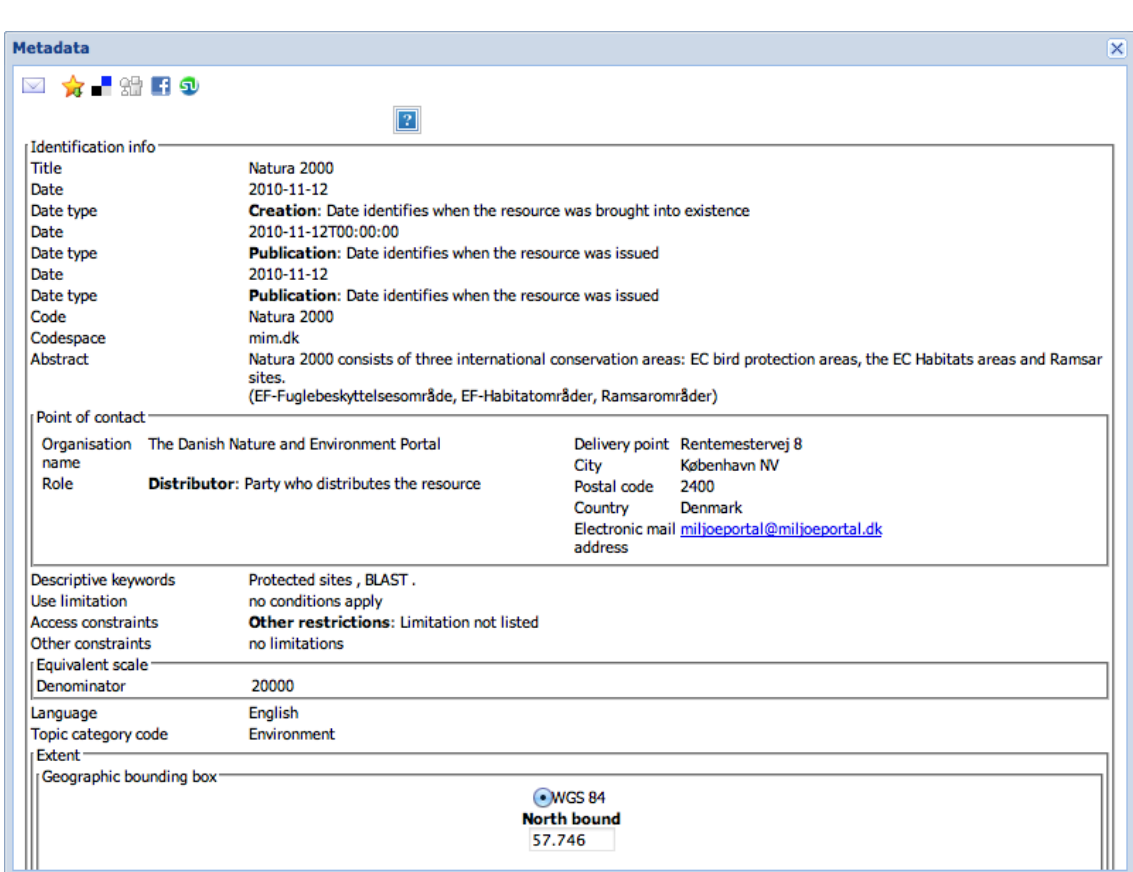
Figure 6. A Metadata view from the COINS system based on